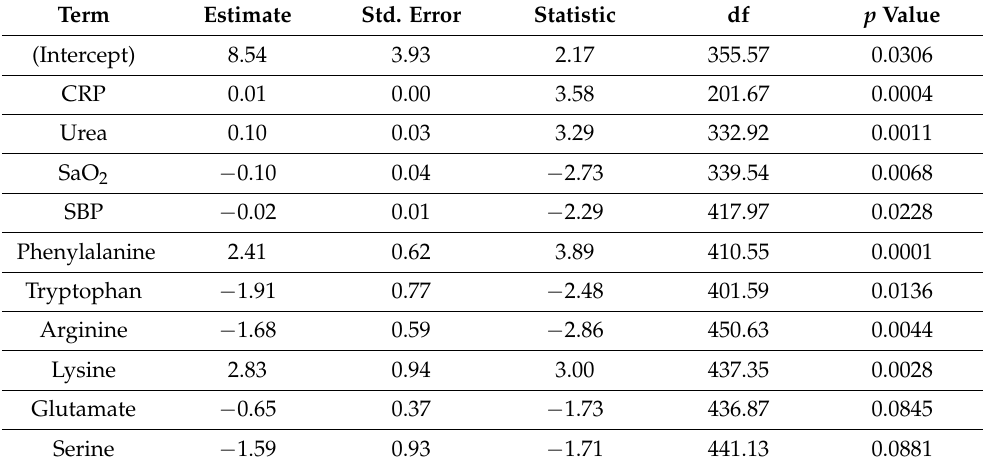
Table 3. Results from the multivariate logistic-regression model to predict adverse outcomes. Term